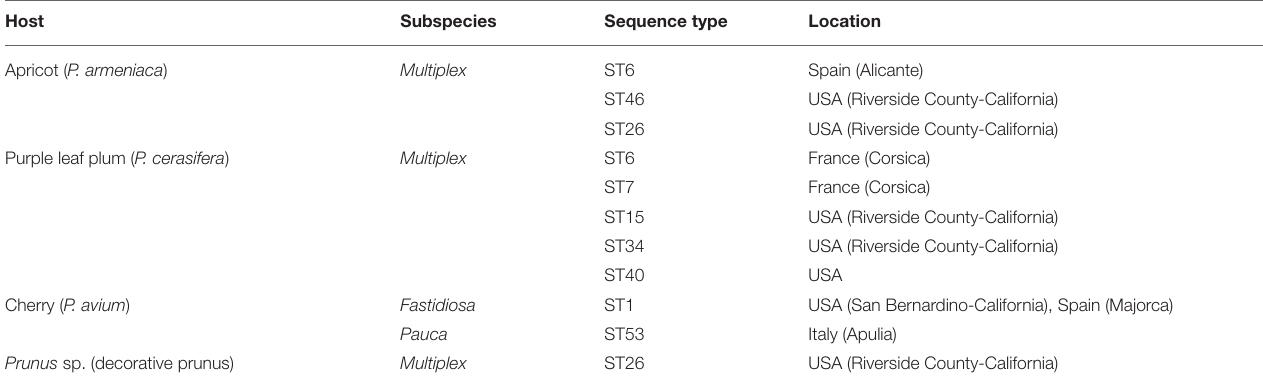
TABLE 3 | Sequence types found in other Prunus species and locations (EFSA, 2020; www.pubmlst.org).